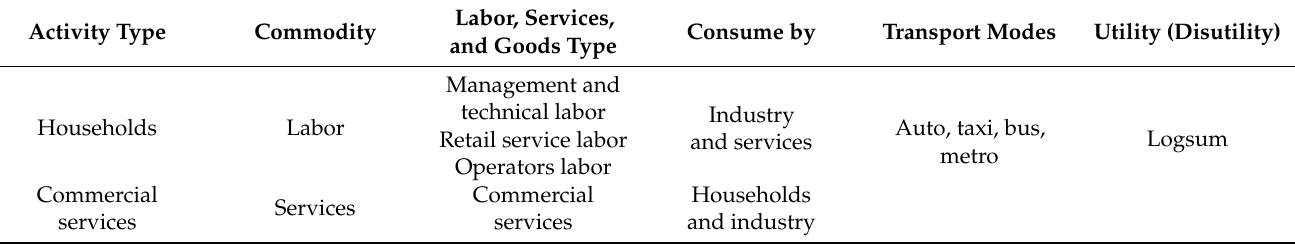
Table 4. Locational preferences of activities parameters.